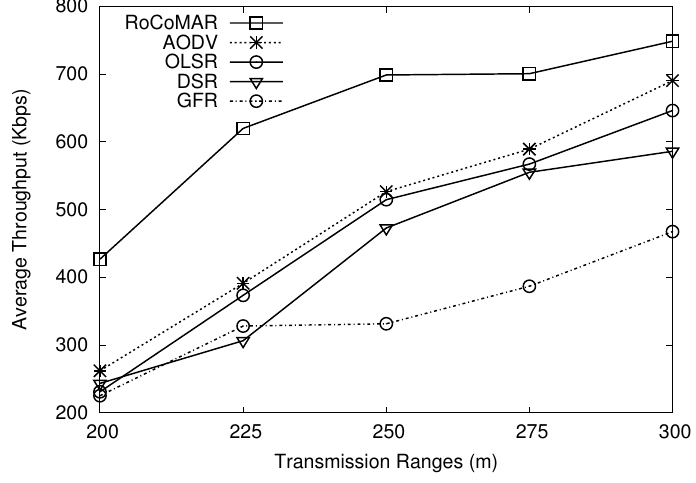
Figure 13. Effects of transmission range on average